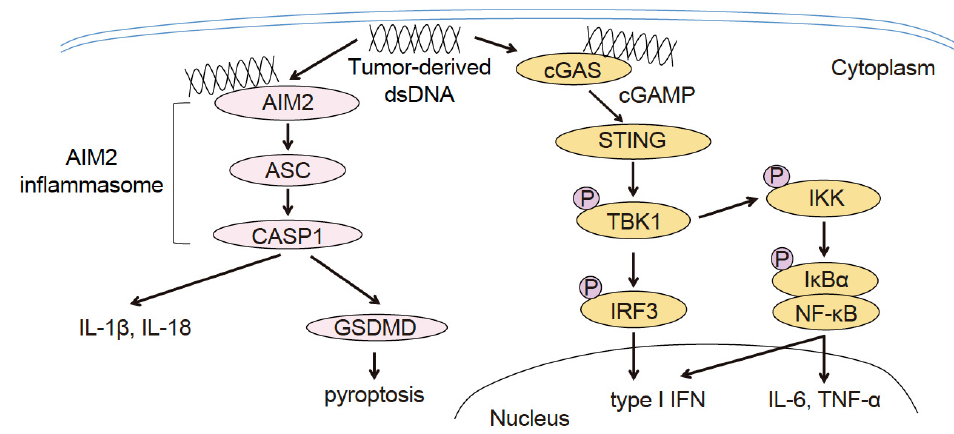
Figure 1. Innate immune signaling pathway that recognizes cytosolic DNA in tumor-infiltrating dendritic cells (TIDCs). dendritic cells